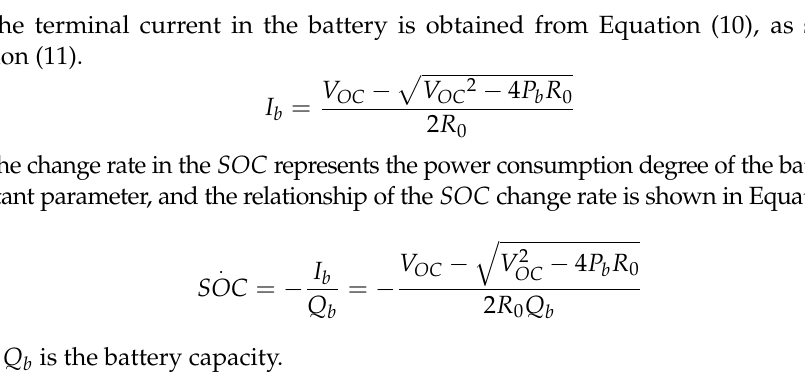
Figure 4. The battery of discharging/charging internal resistance diagrams.